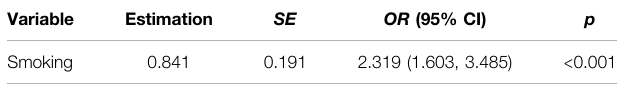
TABLE 1 | Sample characteristics and differential cell-type proportions. TABLE 2 | The estimation of smoking by logistic regression.